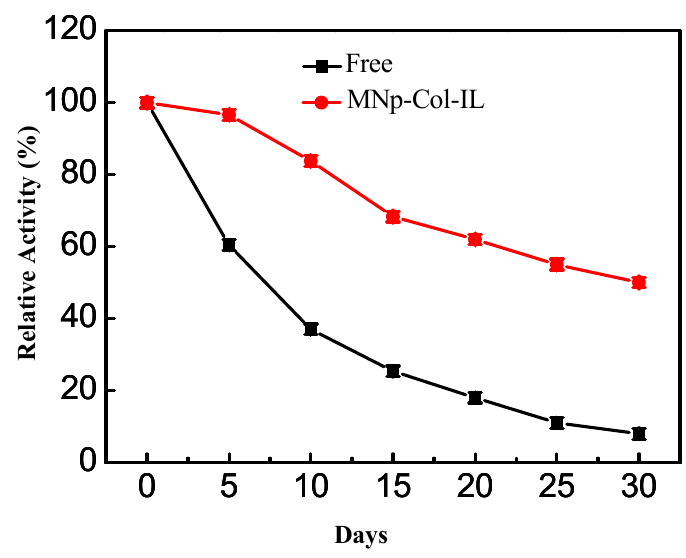
Figure 7. Storage stability of free and immobilized lipase.